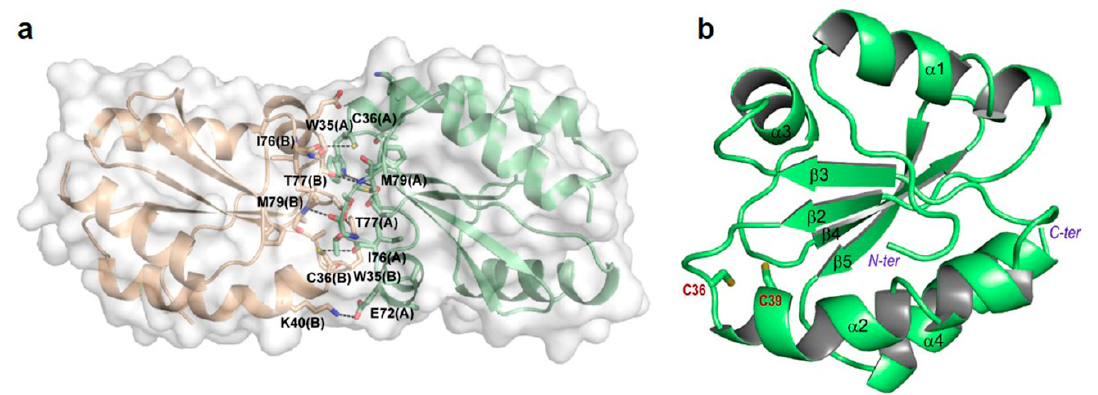
Figure 3. Crystal structure of red-CrTRXh1. ( a ) Cartoon representation of the asymmetric unit dimer. The dimer surface is shown in light gray. The interface interactions are shown, and the corresponding distances are indicated in Table S1. ( b ) Cartoon representation of the monomer structure. The secondary structure elements are shown, and the catalytic Cys36 (C36) and Cys39 (C39) are represented as sticks.